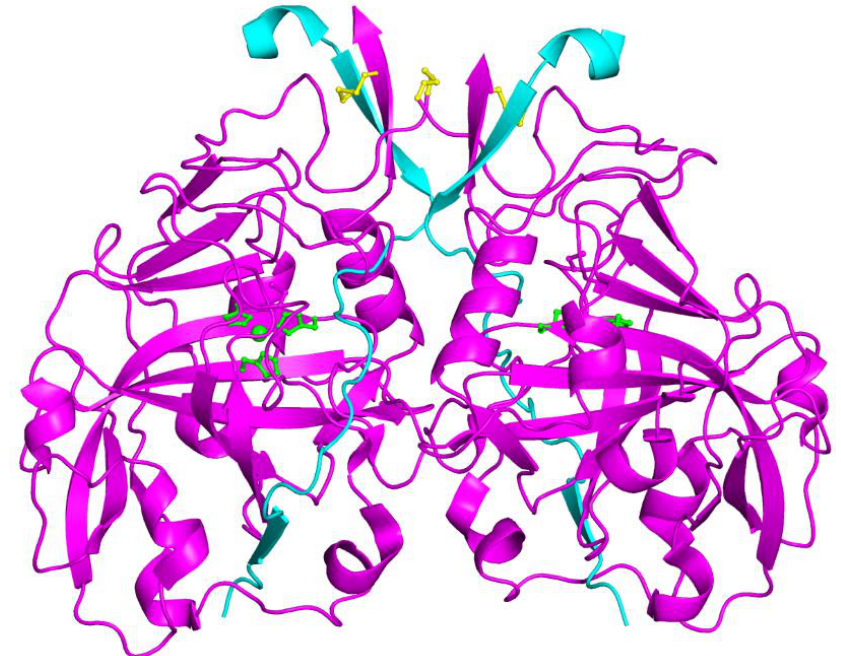
Figure 2. Cartoon representation of the CAH1 dimer. For both monomers, the big subunits are colored in magenta, while the small subunits in cyan. Disulfide bonds between the two monomers and between big and small subunits are reported in yellow. The zinc ions and their coordinating histidines are also shown in green.